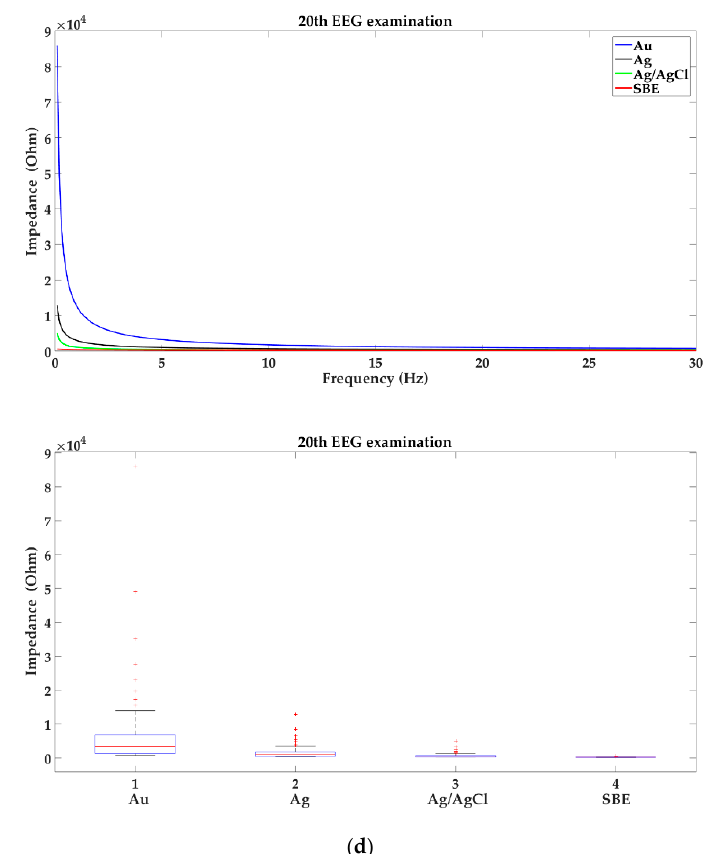
Figure 5. Impedance characteristic of the electrodes: gold (Au), silver (Ag), silver/silver chloride (Ag/AgCl) and sintered bridge electrodes (SBE) in the brain activities 0.1–30 Hz after ( a ) the first; ( b ) the fifth; ( c ) the tenth; and ( d ) the twentieth EEG examinations with analysis of the variability of impedance. Within the box, a horizontal red line means the median value of the data set; whereas the bottom and top blue lines of the box indicate the 25th and 75th percentiles, the whiskers present min and max and the outliers are marked with the ‘+’ symbol.